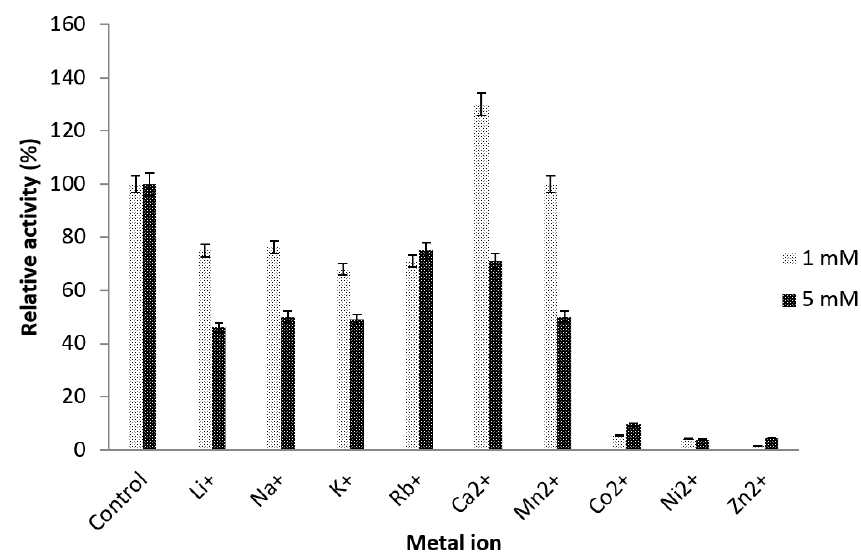
Figure 9. Effects of metal ions on truncated AMS3 lipase stability. Truncated AMS3 lipase activity was enhanced in the presence of a few metal ions. The enzyme was pre-incubated at 60 °C with various metal ions at concentrations of 1 and 5 mM.